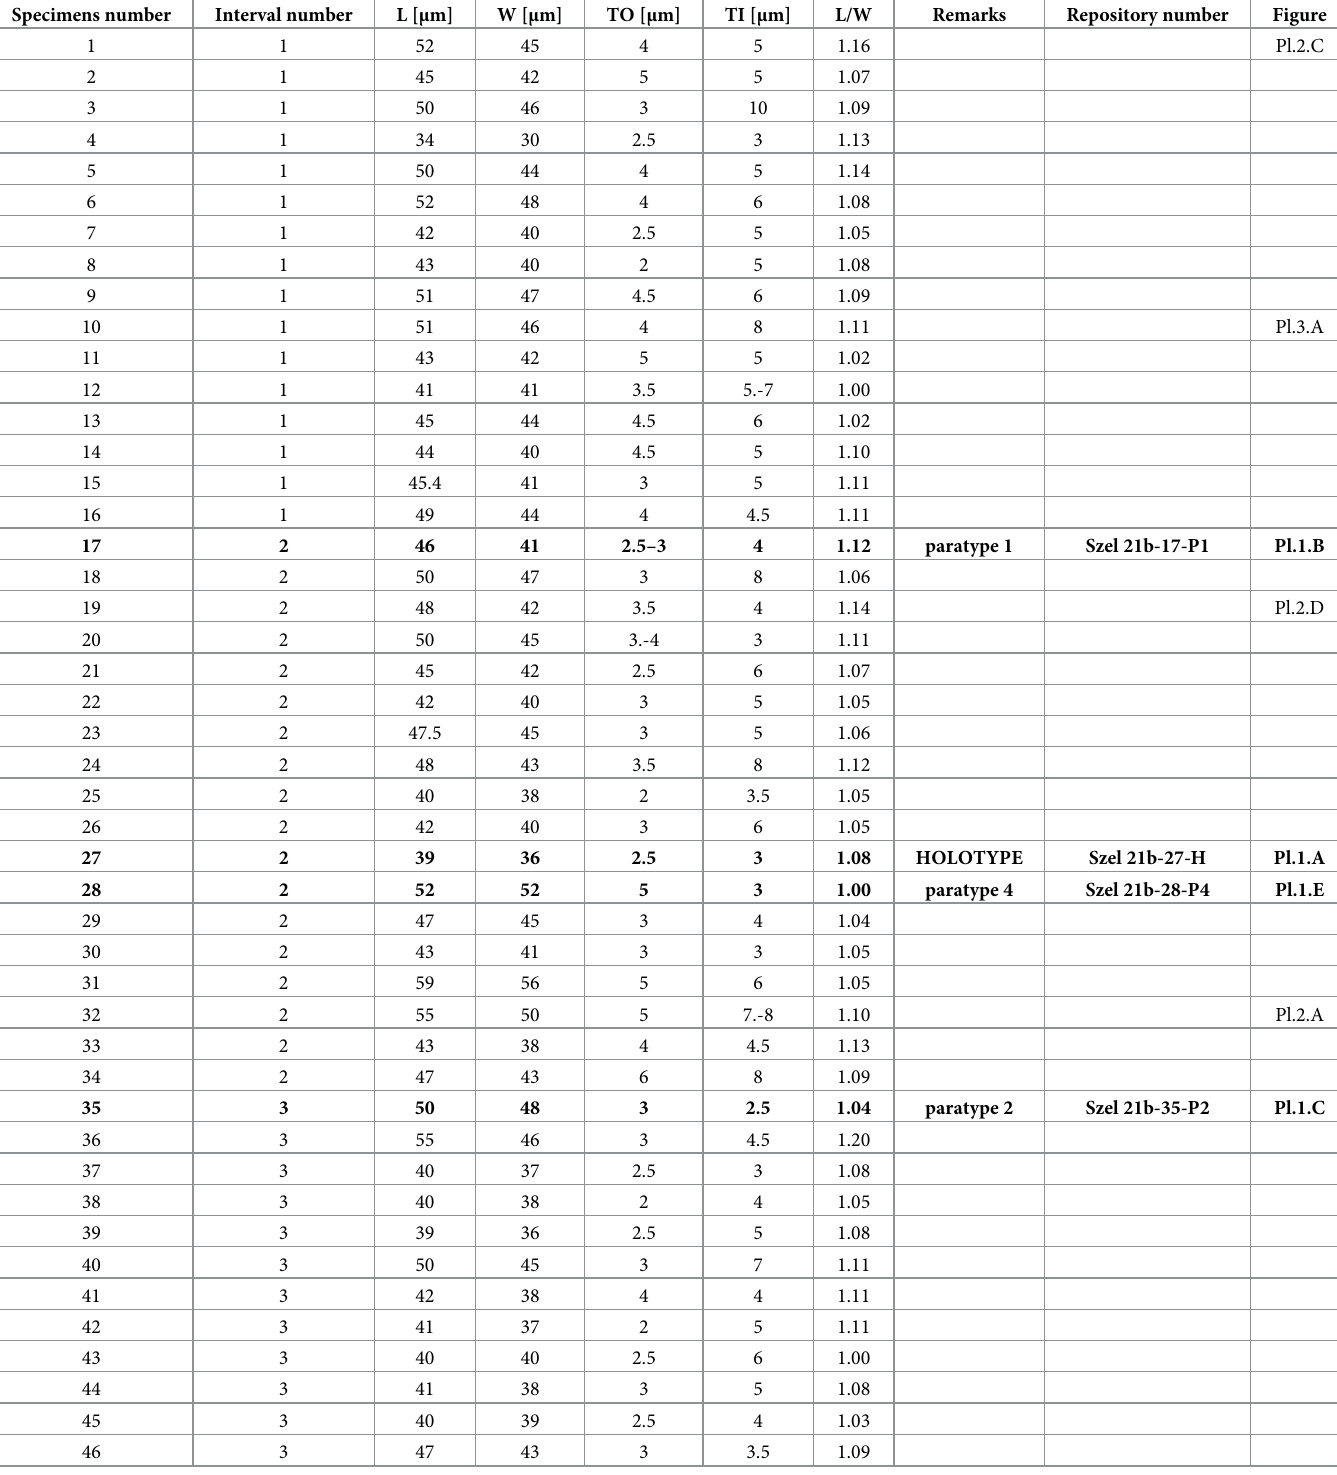
Table 1. Dimensions of the specimens of Cadosinopsis rehakovii sp. nov., specimens 1–81 measured from thin section no. Szel 21b and specimen 82 from thin sec- tion no. Szel 21a. Specimens